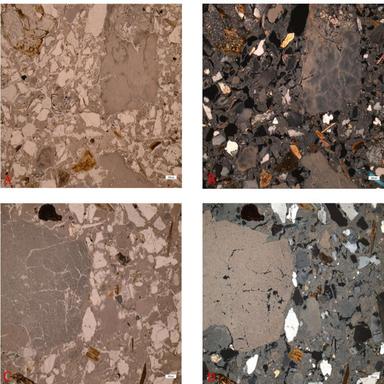
Photomicrographs of lime lumps in transmitted light, parallel (A-C) and crossed polars (B-D). Top images: sample HG_S_AL_01, on the right a lime lump with microcraks and silicate phases at the top can be seen. Bottom images, sample HG_S_AR_03, a porous lime lump with a network of fine micro-cracks is shown on the left. Measurement reference bar = 200 μm.